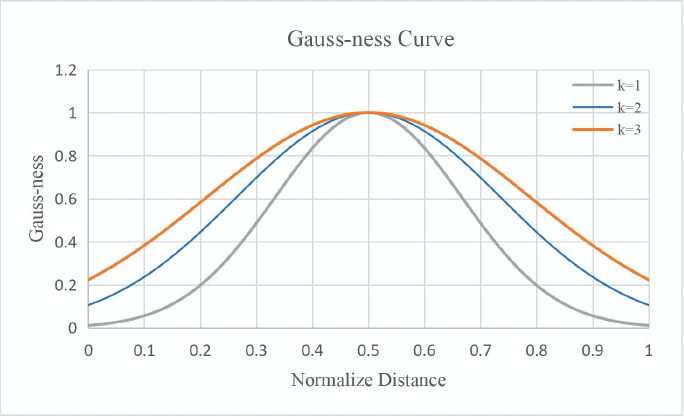
Figure 9. Gauss-ness curves at different K